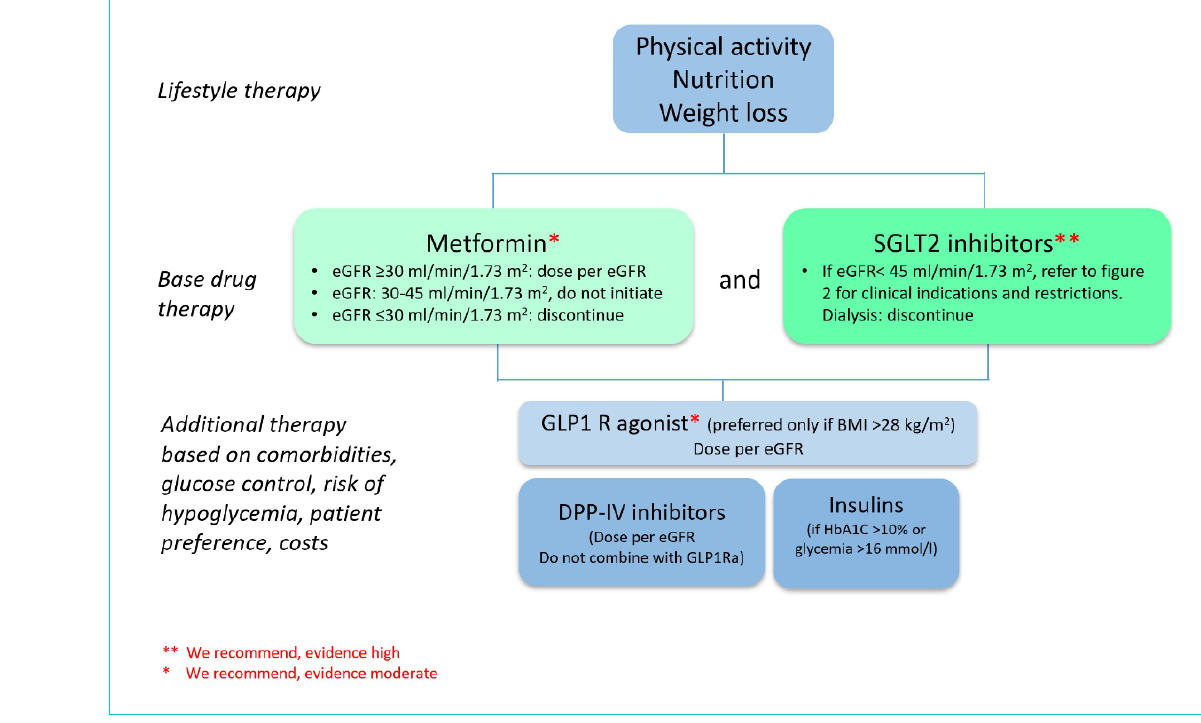
Figure 2: Antidiabetic therapy in chronic kidney disease stage G1–3 A2–3 (modified from: Kidney Disease: Improving Global Outcomes (KDI- GO) Diabetes Work Group. KDIGO 2020 Clinical Practice Guideline for Diabetes Management in Chronic Kidney Disease. Kidney Int. 2020 Oct;98(4S):S1-S115 [1]). Per eGFR see figure 1. Comment: dual SGLT2 inhibitor – GLP1 agonist therapy is under investigation. Preliminary results demonstrate additional effects on weight, blood glucose and blood pressure